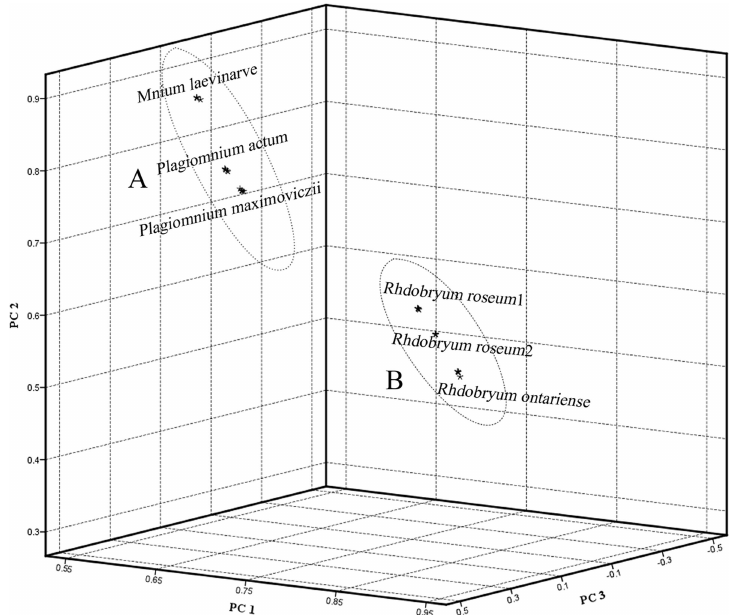
Fig 4. 3D Plot of FTIR Spectra of the 6 Species of Mosses (5 Replicates for Each Sample) Based on